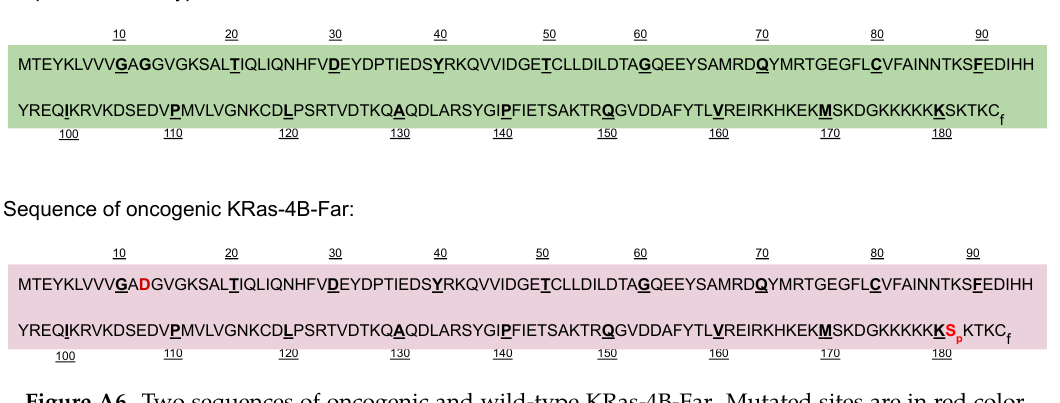
Figure A6. Two sequences of oncogenic and wild-type KRas-4B-Far. Mutated sites are in red color. Here C f denotes the farnesylated Cys-185 and S p represents the phosphorylation adopted in the present